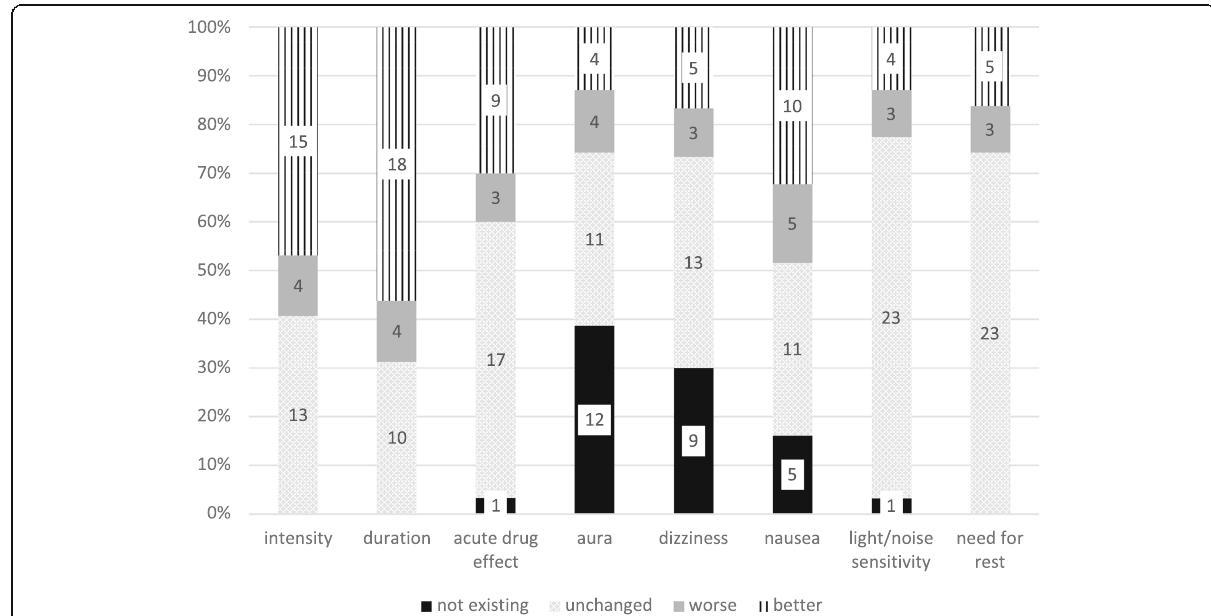
Fig. 2 Migraine characteristics. Changes of migraine characteristics after three months of treatment. The relative proportion and the absolute number of patients who noticed the respective change are noted. All non-existent, non-applicable and non-occurring events are summarised under not